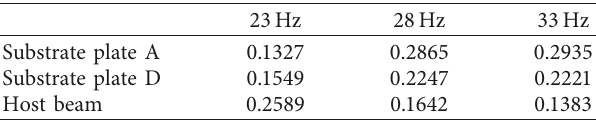
Table 4: Averaged velocity (m/s) of the linear EMM system in 100 seconds.